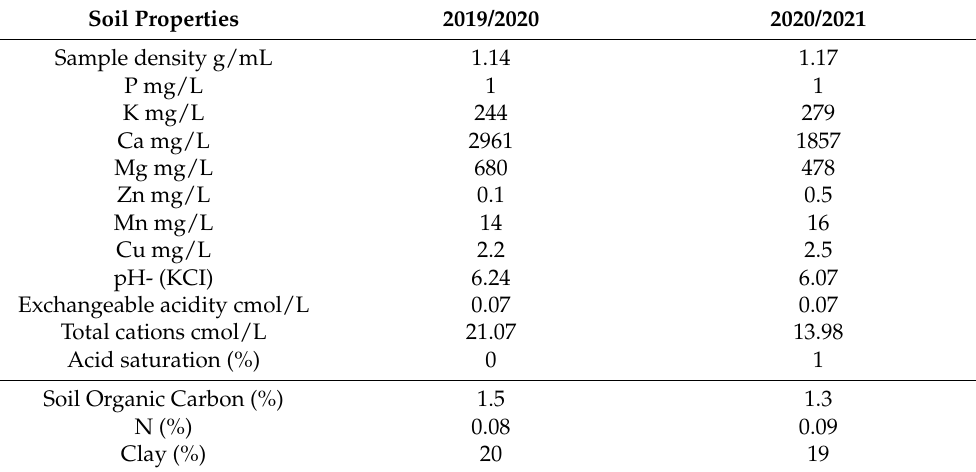
Table 7. Physical and chemical characteristics of the field trial soil. Soil